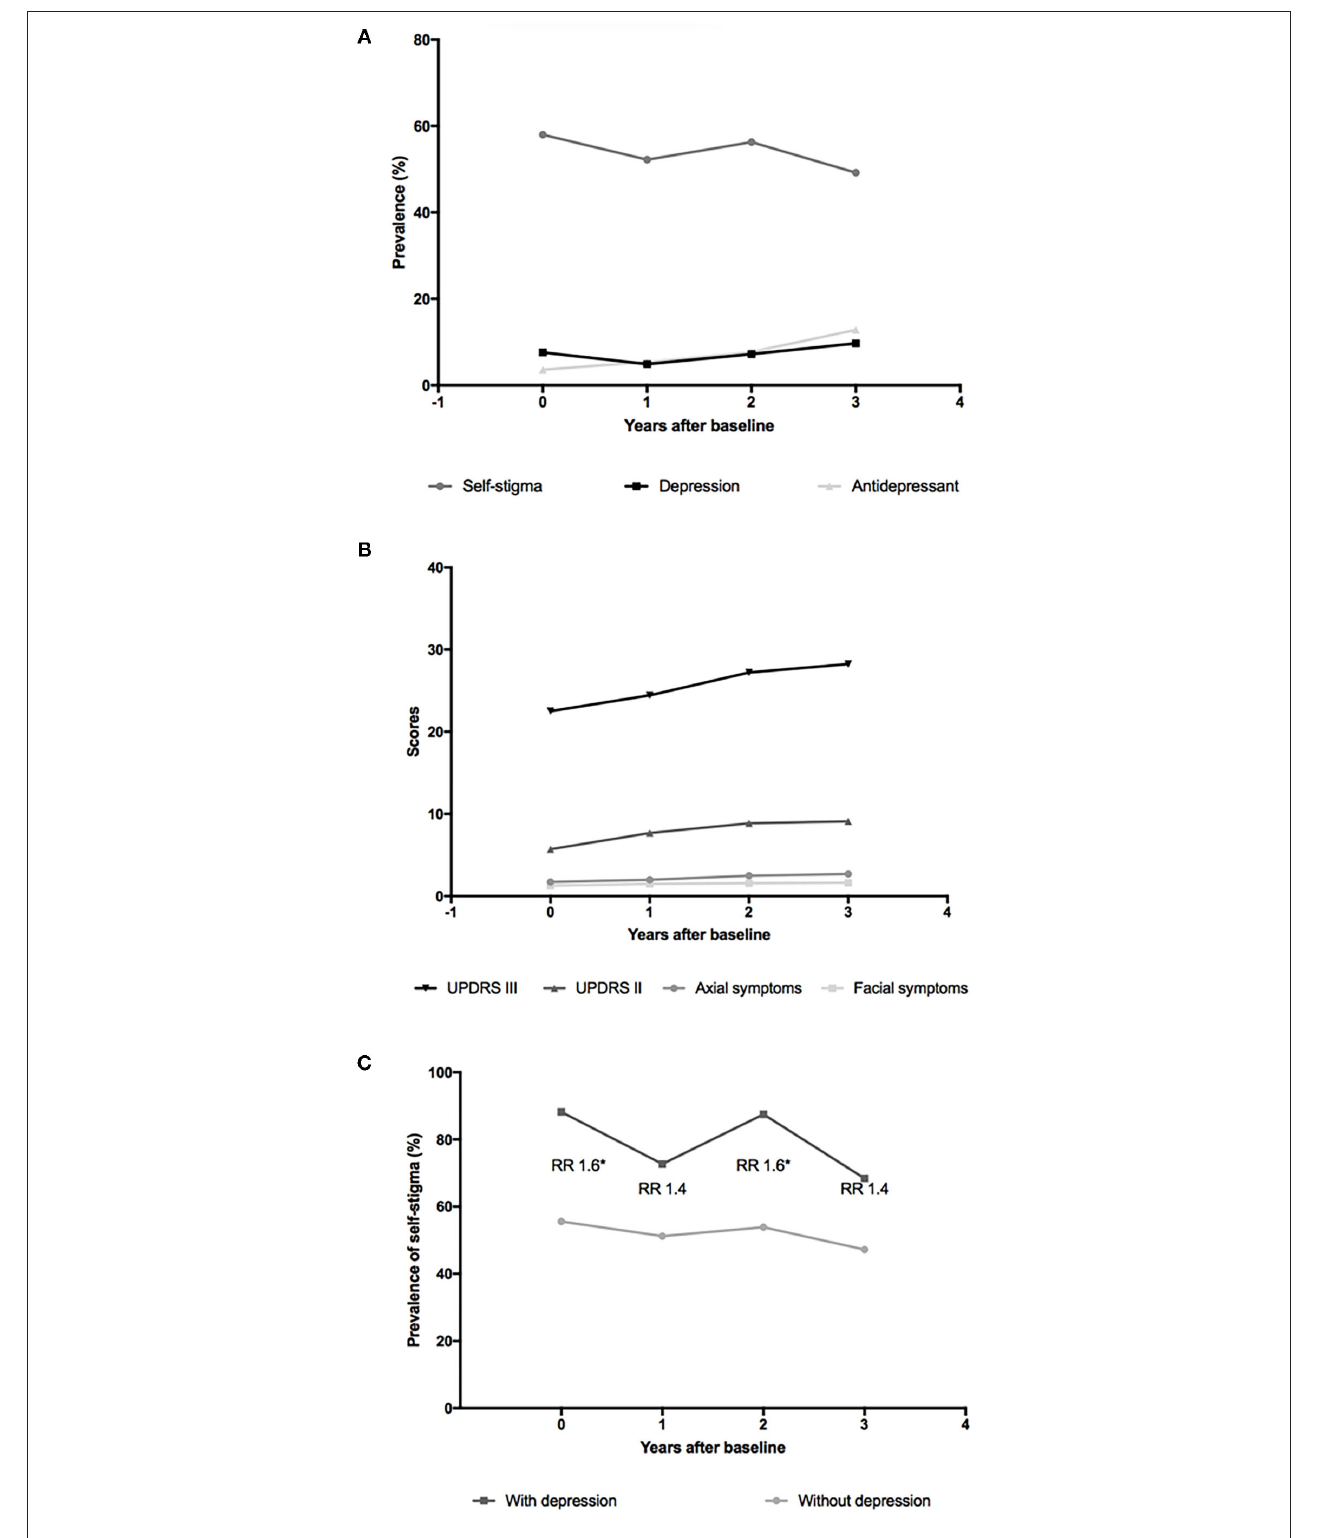
FIGURE 2 | Evolution of self-stigma and other symptoms in patients with PD over 3 years. (A) Point prevalence of self-stigma, depression, and antidepressant use in patients with PD over 3 years; (B) Scores of Unified Parkinson’s Disease Rating Scale Part II (UPDRS II), UPDRS III, axial symptoms, and facial symptoms in